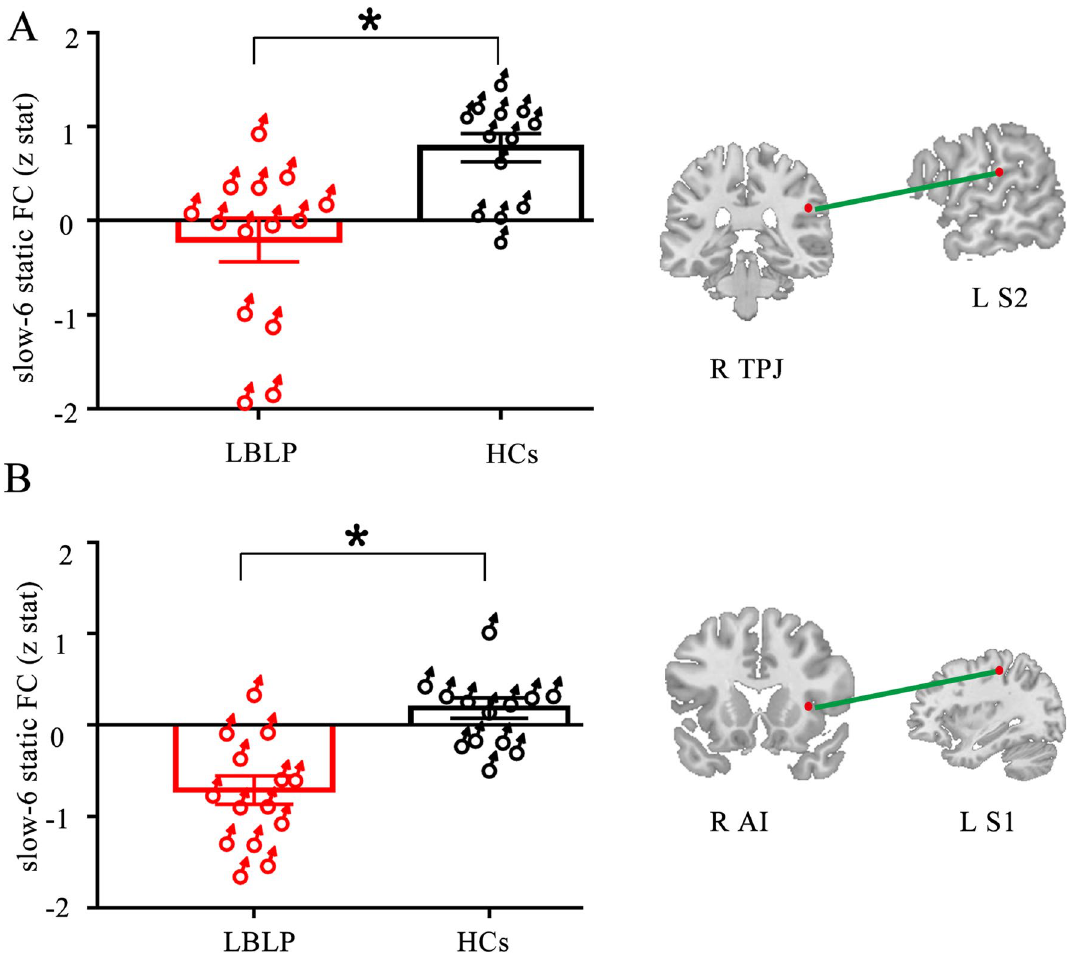
Figure 4. Male-specific analysis of differences between the LBLP and HCs groups. Two-sample t test, P < 0.05 with FDR